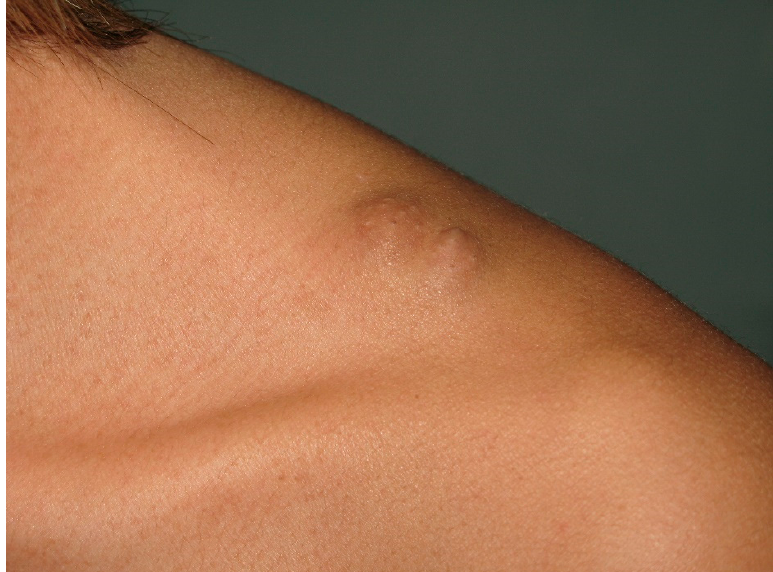
Figure 9. Isolated neurofibroma of supraclavicular region.